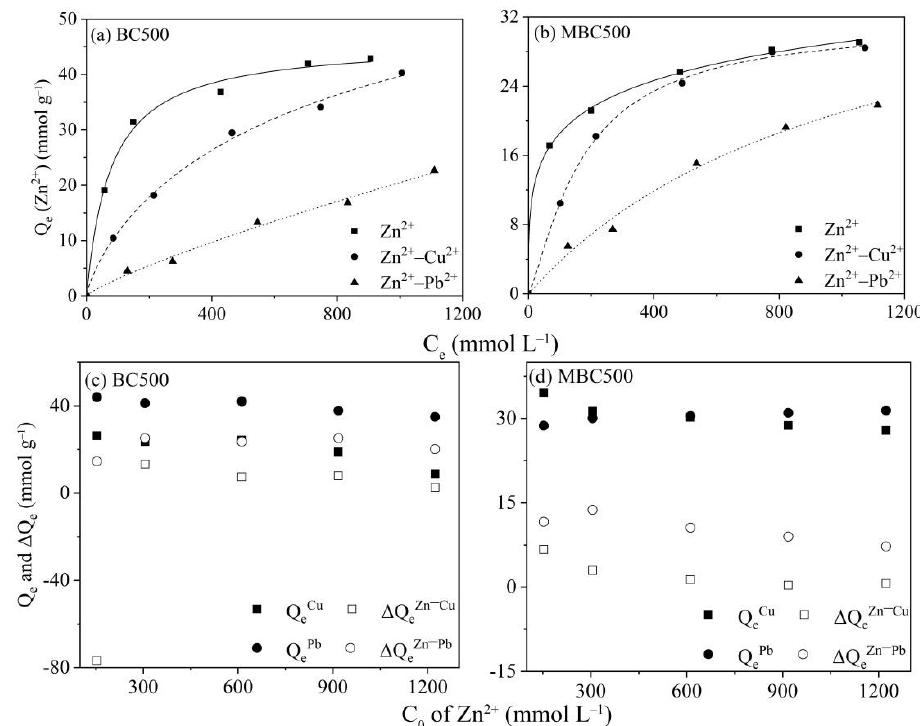
Figure 3. Effect of Cu 2+ /Pb 2+ on adsorption capacity of Zn 2+ on BC500 ( a , c ) and MBC500 ( b , d ) (Q eCu and Q ePb represent the adsorption capacities of Cu 2+ and Pb 2+ in the binary metal system; ∆ Q eZn − Cu and ∆ Q eZn − Pb represent the ∆ Q e of Zn 2+ in Zn 2+ –Cu 2+ and Zn 2+ –Pb 2+ competitive sys- tems).